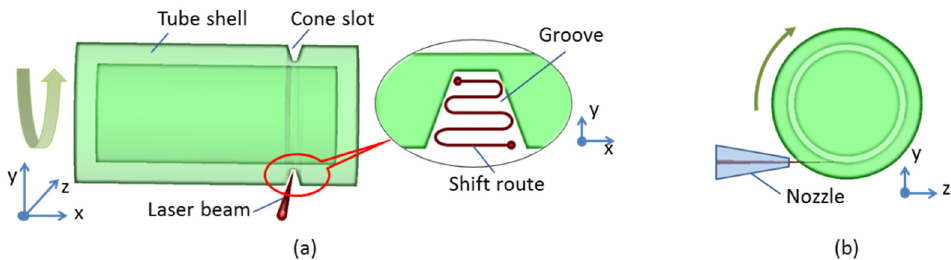
Figure 3. Configuration of the high-power fiber laser process: ( a ) schematic representation of laser beam action and drawing of the cut geometry; ( b ) cross-section view.